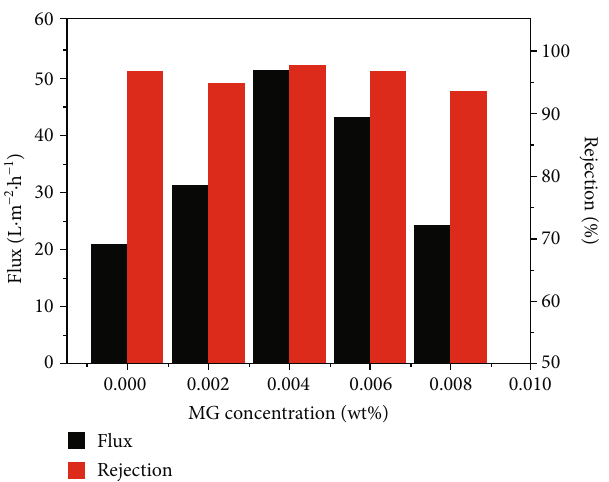
Figure 5: Water fl ux and rejection of membranes prepared with di ff erent MG